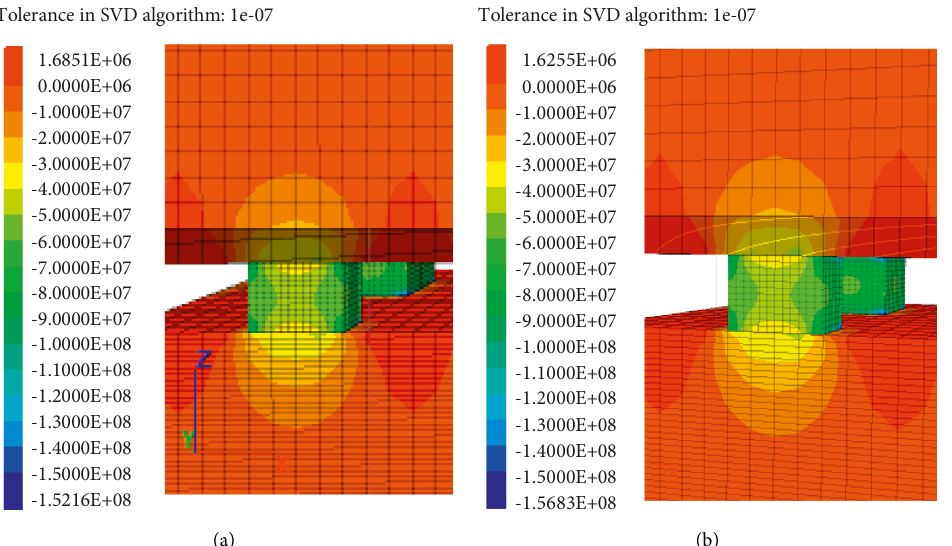
Figure 6: Pillar under combined stresses (lithostatic and dynamic stresses). (a) Square section dimensions obtained with the Obert and Duvall equation (1967), as in Section 3.5.4 (2.66 m 2.66m). (b) Rectangular section dimensions obtained with the Mark and Chase × equation (1997), as in Section 3.5.4 (2.66 m 2.63 ×